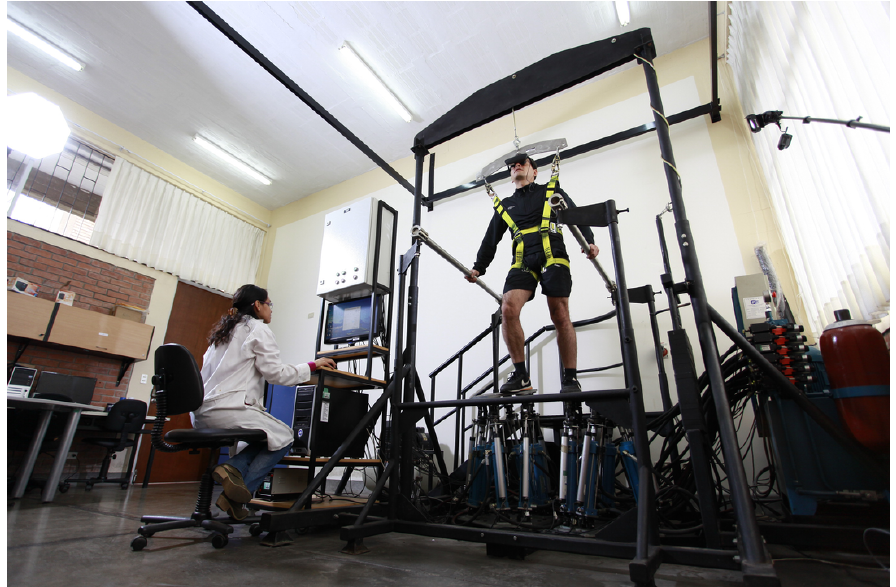
Figure 1. Gait simulator based on two Stewart–Gough platforms. During therapy, a user stands on both platforms, while a therapist supervises the system operation. Several safety measures have been implemented to protect the patient. A schematic describing the elements presented in this figure is provided in Figure